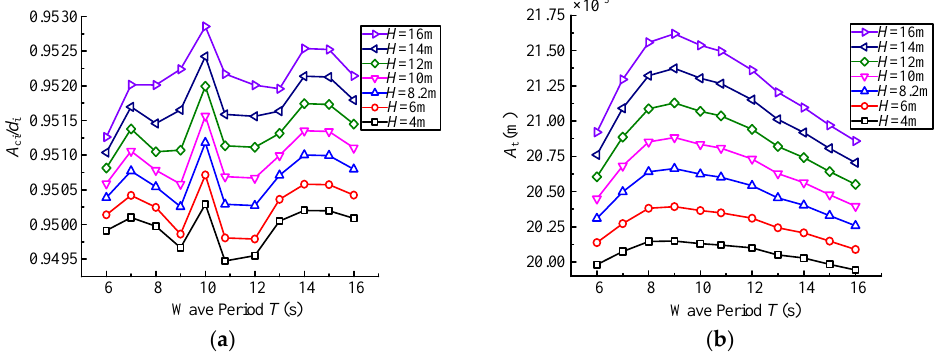
Figure 8. Maximum amplitude of cables or tube with different wave period T and wave height H (frozen parameters: GBR = 0.65, IMA = 90° and v 0 = 1.18 m/s): ( a ) A ci / d i of cables; ( b ) A t of tube.